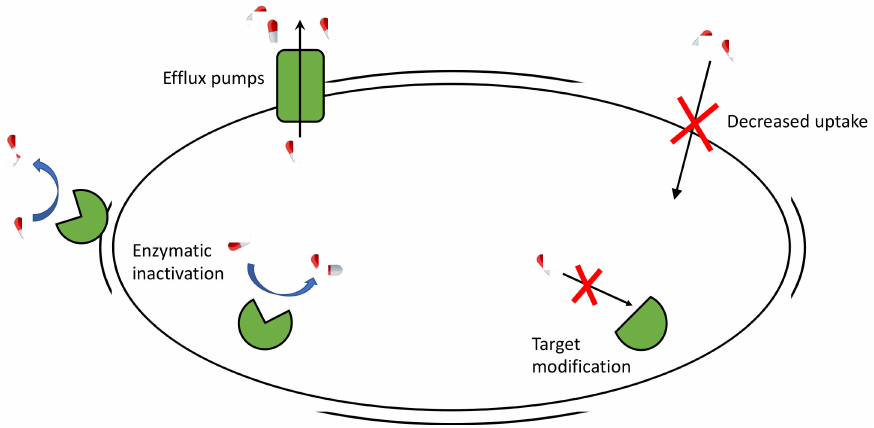
Figure 2. Cartoon representation of di ff erent mechanisms of antibiotic resistance. Antibiotics as red and white pills, target proteins in